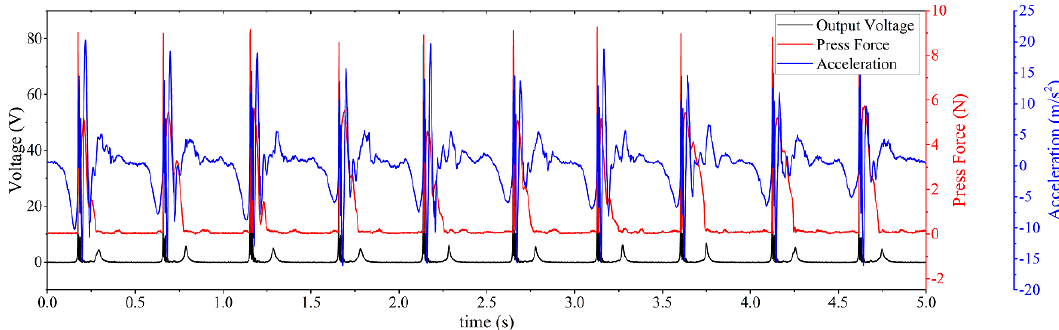
Figure 4. Typical synchronized measured signals during tapping including voltage output of energy harvester, force sensor and accelerometer.